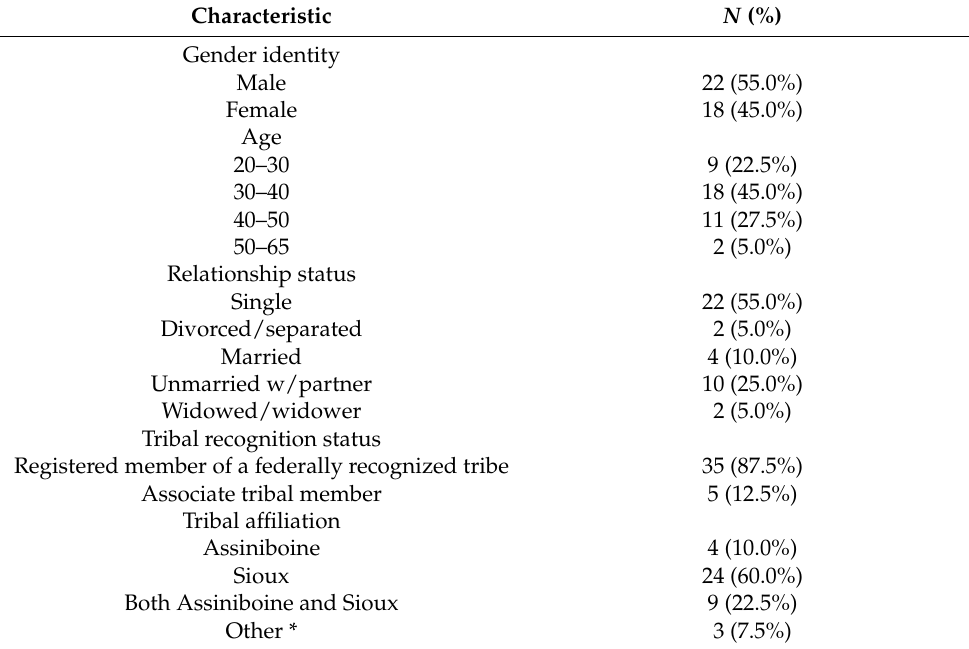
Table 1. Demographic and background characteristics of study participants, n = 40. Characteristic N